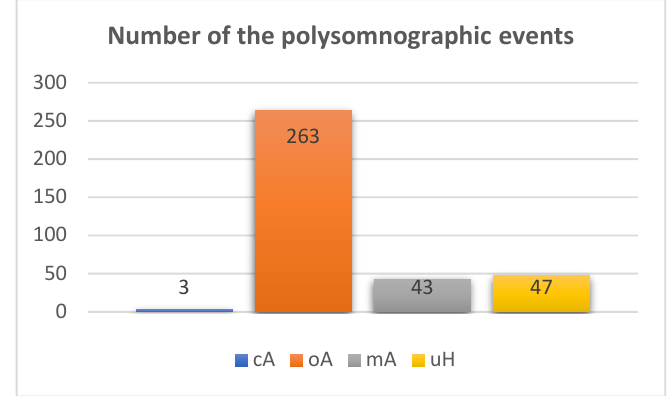
Chart 1. Overview of the polysomnographic events.